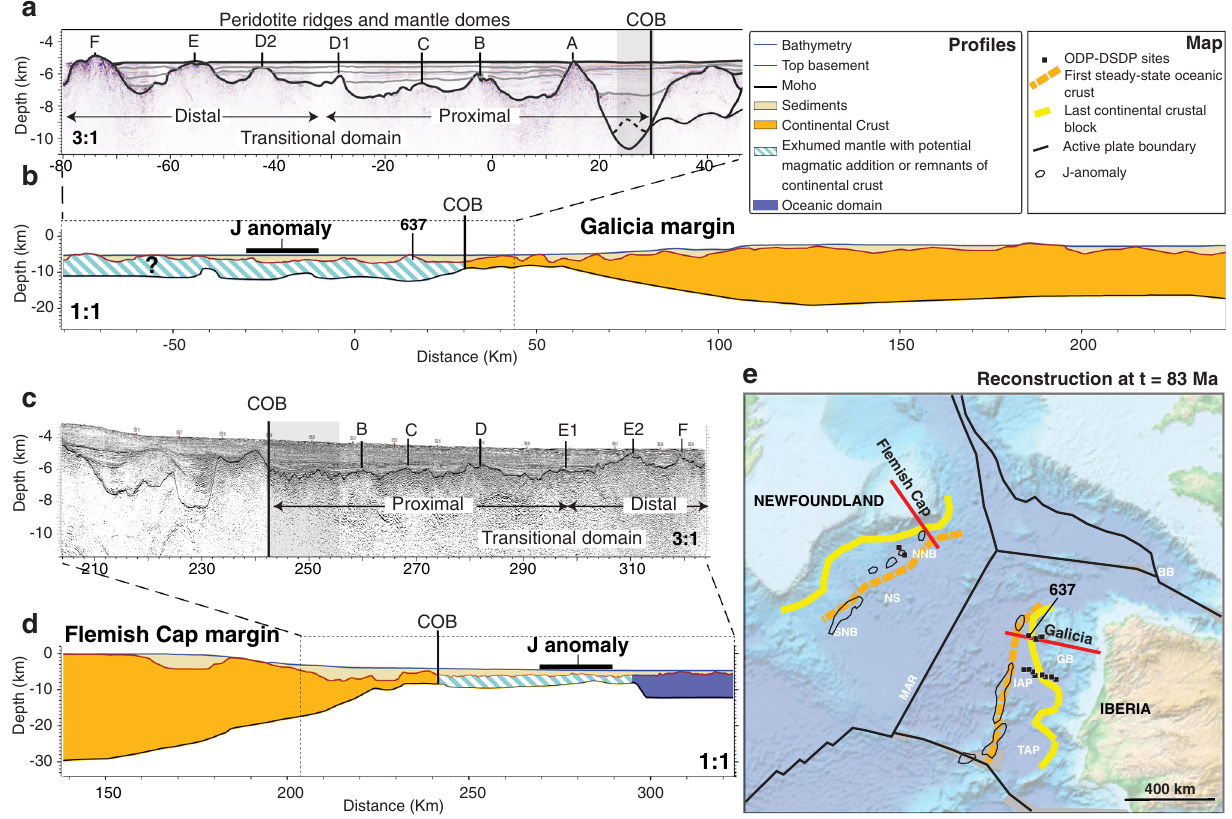
Fig. 1 Iberia/Newfoundland conjugate margins. a Distal part of the seismic re fl ection pro fi le WE-1 on Galicia side 26 . b Large-scale geophysical cross-section of the Galicia margin based on composite ISE-1/WE-1 refraction seismic pro fi les 7,25,26 . Proximal domain not shown. c Distal part of the seismic re fl ection pro fi le SCREECH-1 on Flemish Cap side 6 . d Large-scale geophysical cross-section of the Flemish Cap margin based on the SCREECH-1 deep seismic refraction pro fi le 6,24 . e Map at time C34n (83 Ma) with present-day ETOPO-1 relief, based on G-Plates reconstruction of Matthews et al. 64 . Magnetic J anomaly from EMAG2v3 data set 48 . Note that the magnetic J anomaly is weak and discontinuous at the latitude of the Flemish Cap-Galicia sections. Red lines represent seismic pro fi les used in this study. Orange: Landward limit of oceanic crust. Yellow: Oceanward limit of continental crust. BB Bay of Biscay, GB Galicia Bank, IAP Iberia Abyssal Plain, MAR Mid-Atlantic Ridge, NNB northern Newfoundland Basin, NS Newfoundland Seamounts, SNB southern Newfoundland Basin, TAP Tagus Abyssal Plain, ODP Ocean Drilling Program, DSDP Deep Sea Drilling Program, COB Continent ocean